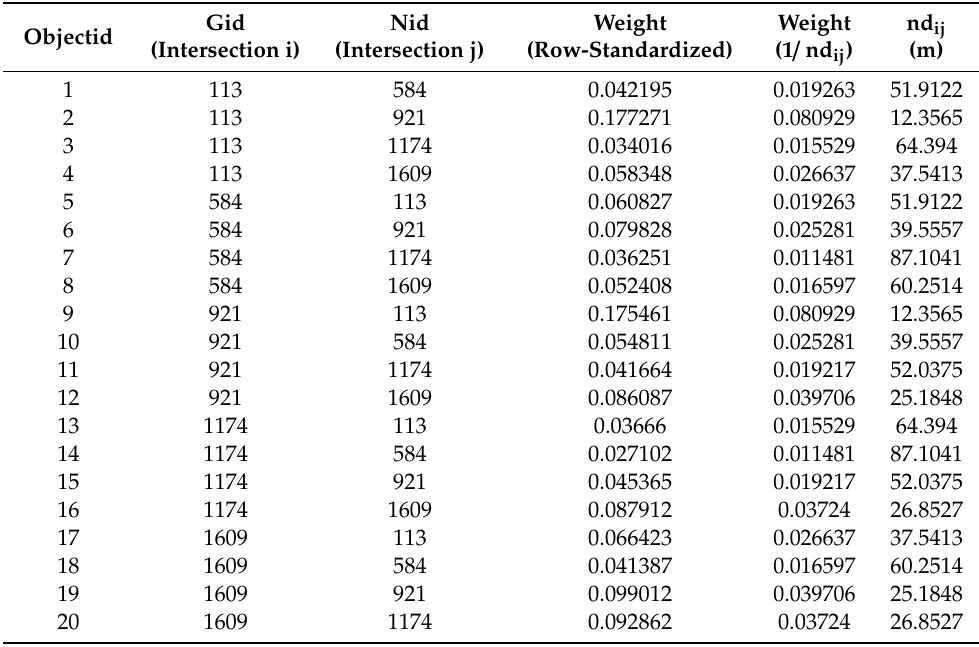
Table 3. The results of the INDSWMI generation